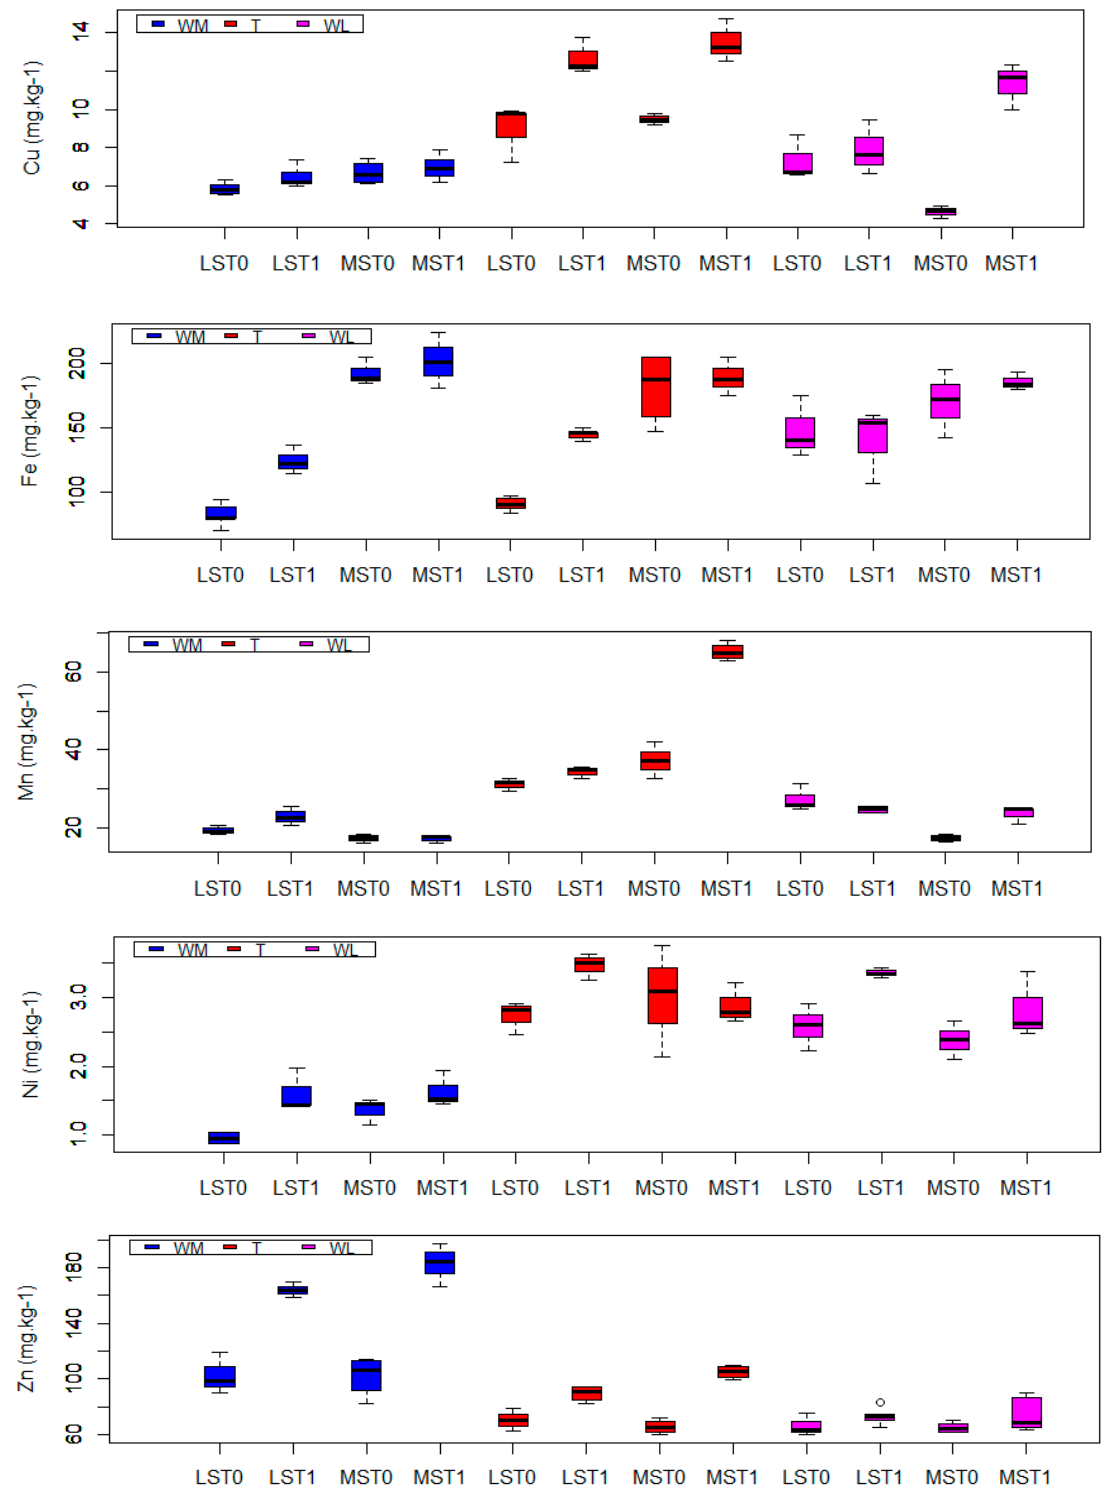
Figure 2. Content of microelements in grain. In the figure, the minimal value, first quartile (Q1), median, third quartile (Q3), and the maximal value are given to display the distribution of data. On the OX axis, the combination of treatments are marked, for more details see description in Material and Methods.